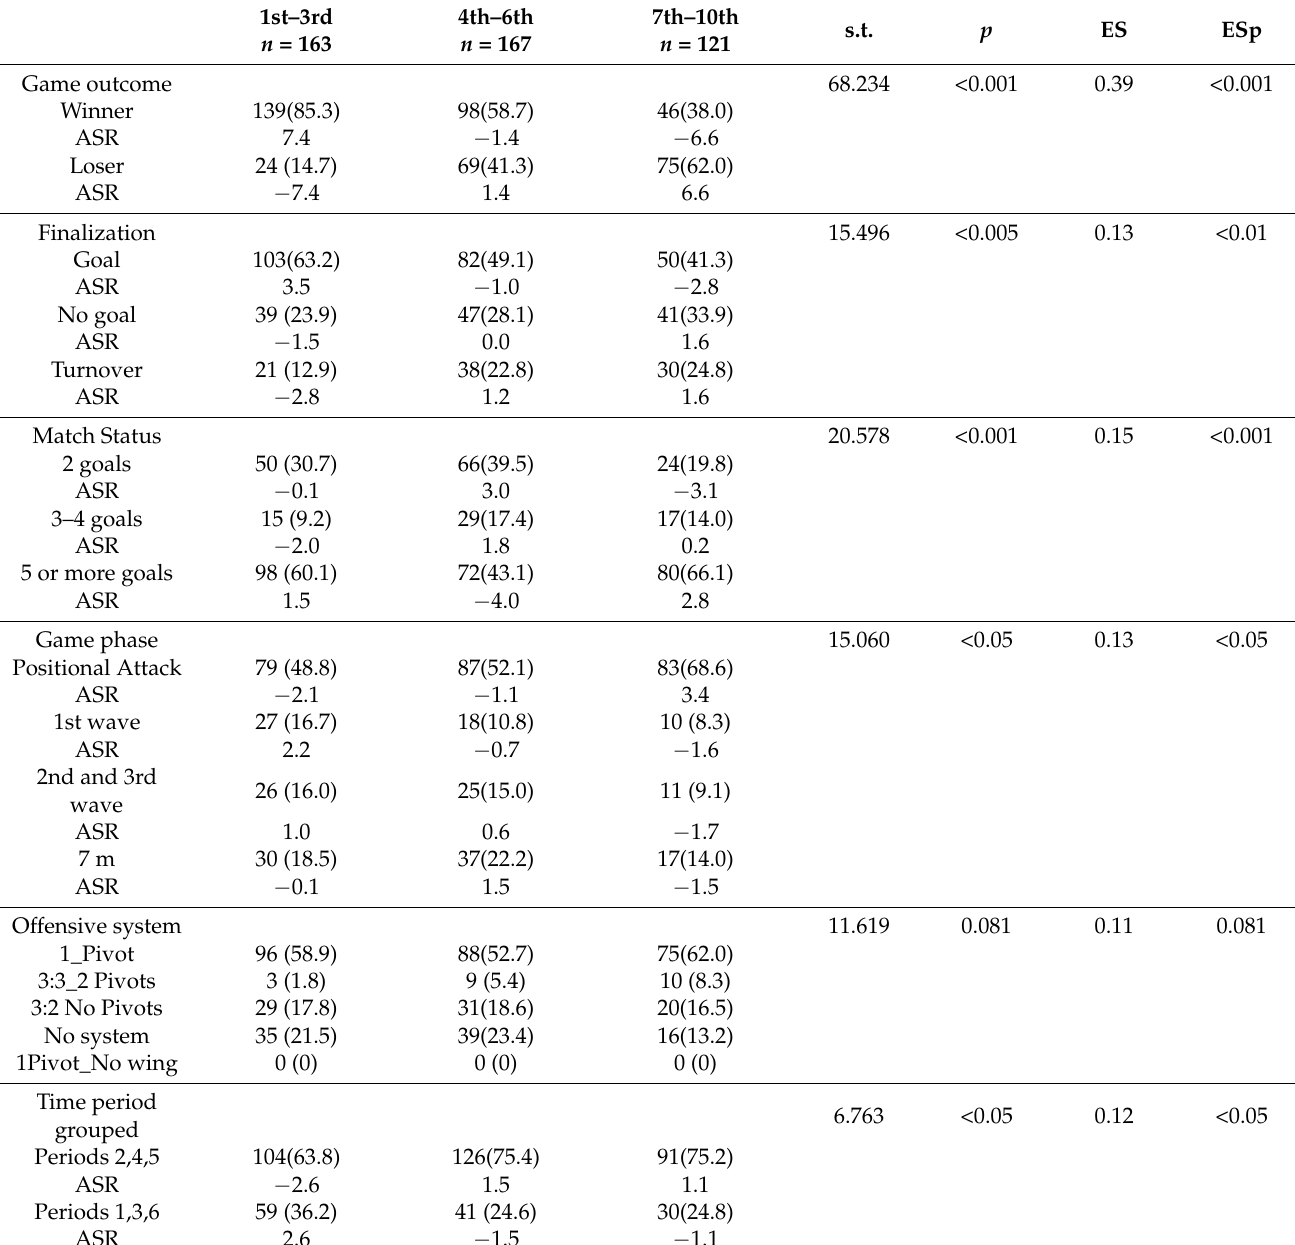
Table 3. Frequency distribution of offensive situations under superiority during the